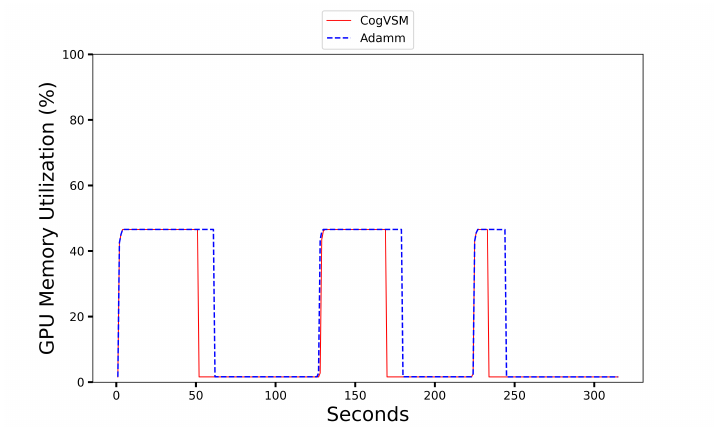
Figure 10. GPU memory utilization on a rural area video of the proposed CogVSM framework compared to the AdaMM framework ( θ m = 30 s for